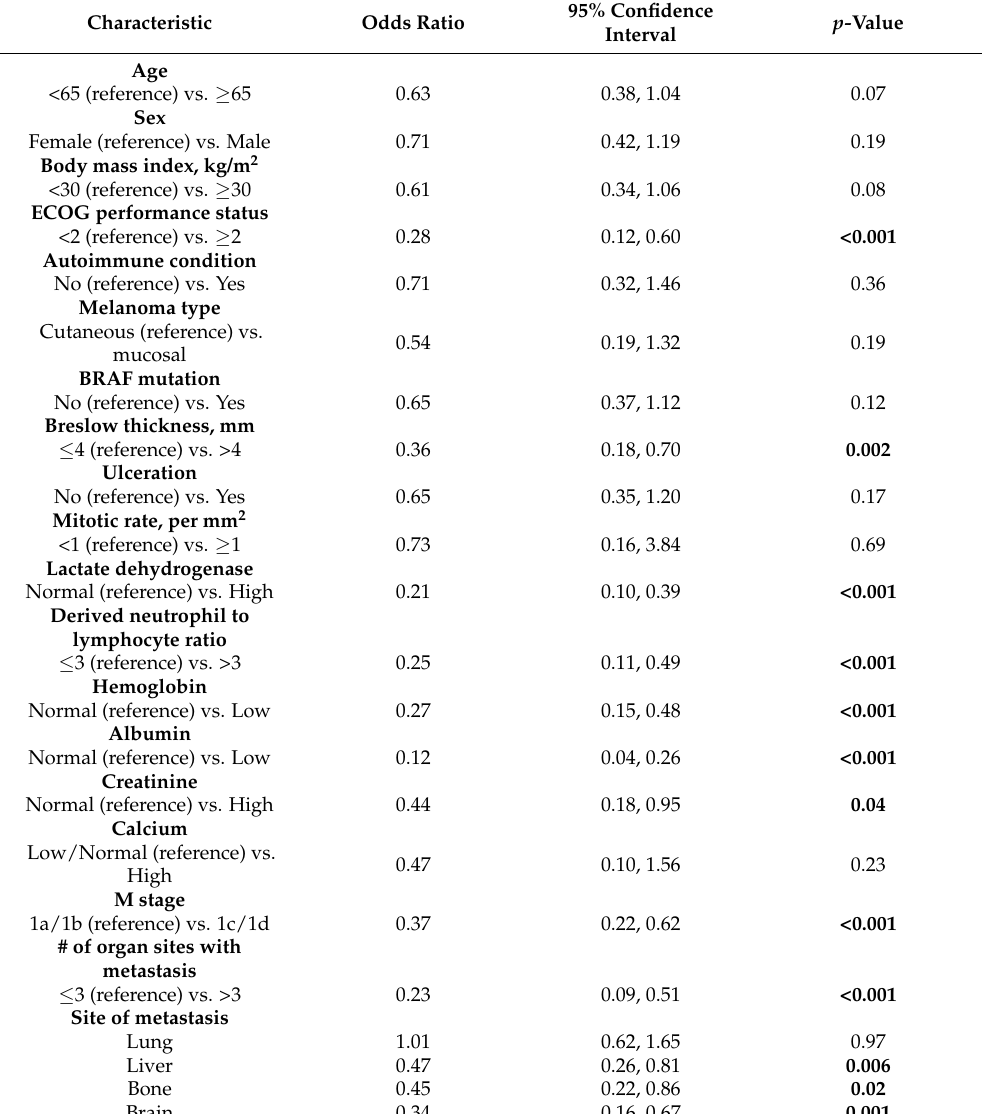
Table 3. Univariable regression analysis of patient factors to determine association with survival >3 years or <1